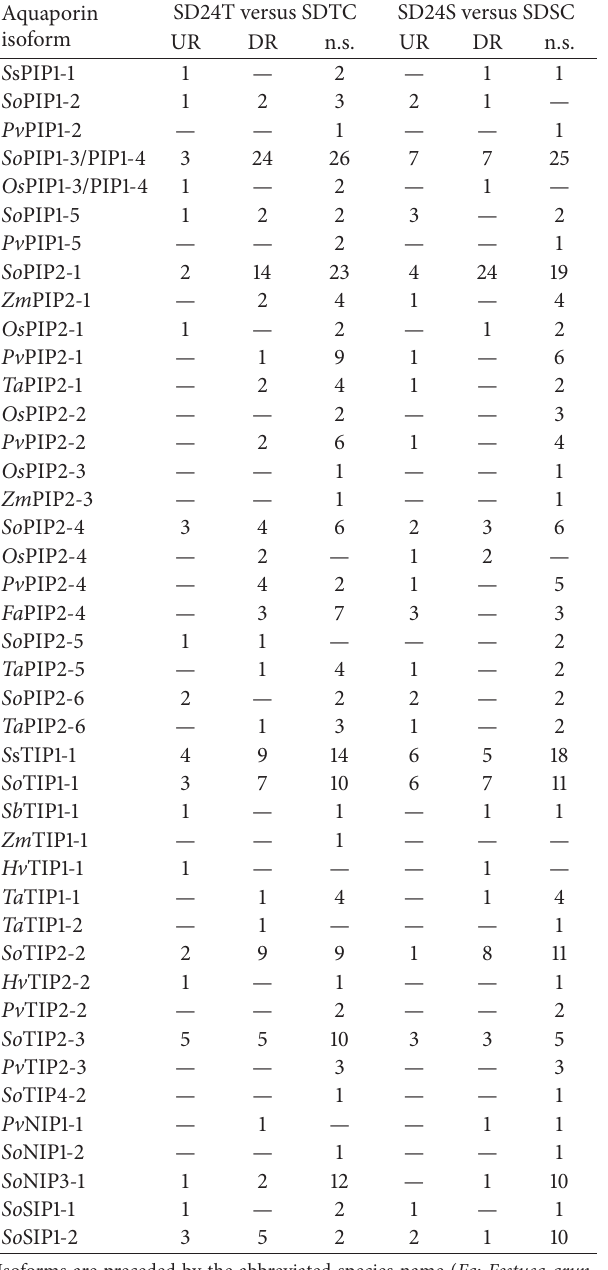
Table 3: The 30 HT-SuperSAGE unitags most expressed and annotated as aquaporins from sugarcane libraries with contrasting genotypes under stress (24 h of continuous dehydration) or normal daily